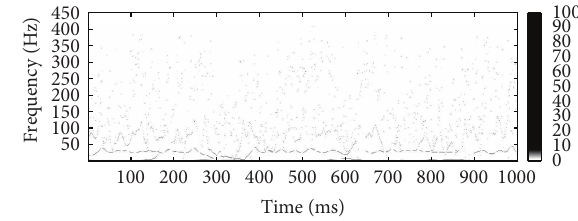
Figure 20: Intensity matrix of fault-free signal.